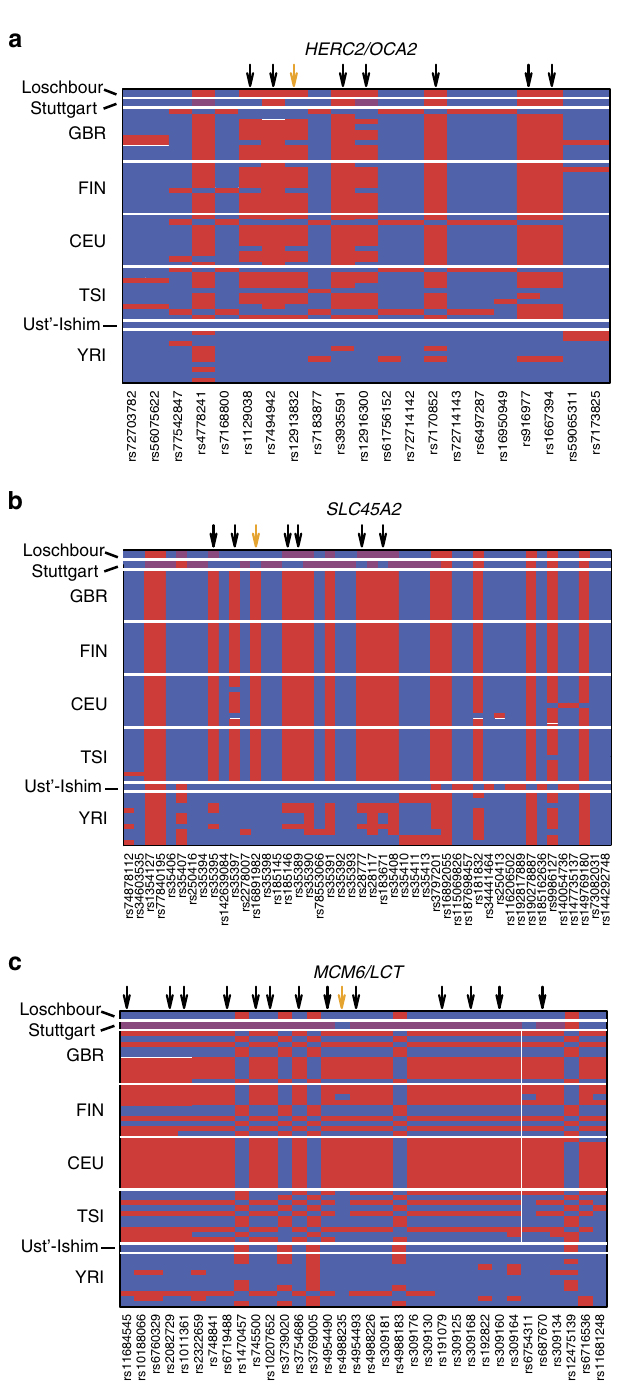
Figure 6 | Haplotypes in ancient and present-day modern humans. Haplotypes for ( a ) OCA2/HERC2 , ( b ) SLC45A2 and ( c ) LCT/MCM6 . SNPs were included if they show moderate to strong LD with the phenotypically relevant SNP ( OCA2/HERC2 : rs12913832, SLC45A2 : rs16891982, LCT/MCM6 : rs4988235), which is marked with an orange arrow. Black arrows indicate alleles that are present in at least one European DAnc tail ( P 2 : GBR, FIN, TSI or CEU). The heatmap shows the phased haplotype for the 1000 Genomes data set (red derived allele and blue ancestral allele) and the genotype for the ancient genomes (red homozygous derived, purple heterozygous and blue homozygous